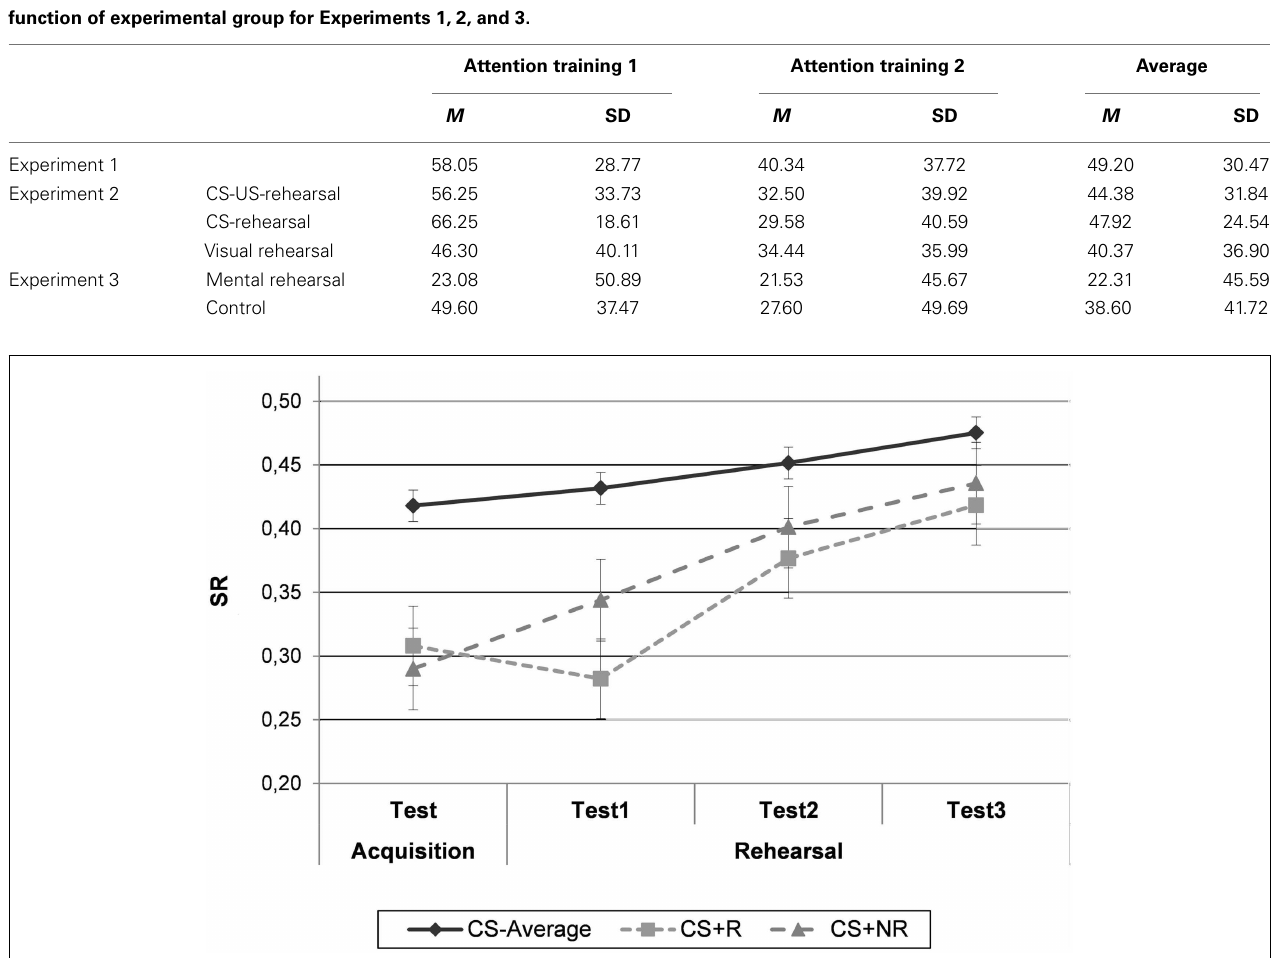
FIGURE 2 | Experiment 1 . Mean suppression ratio’s (SR) as a function of phase (acquisition test, rehearsal test 1, rehearsal test 2, and rehearsal test 3) and CS-type (CS − Average , CS + R , and CS + NR ). CS − Average = the average for both CS − ‘s. CS + R = rehearsed CS + , CS + NR = non-rehearsed CS + . Error bars denote standard error.